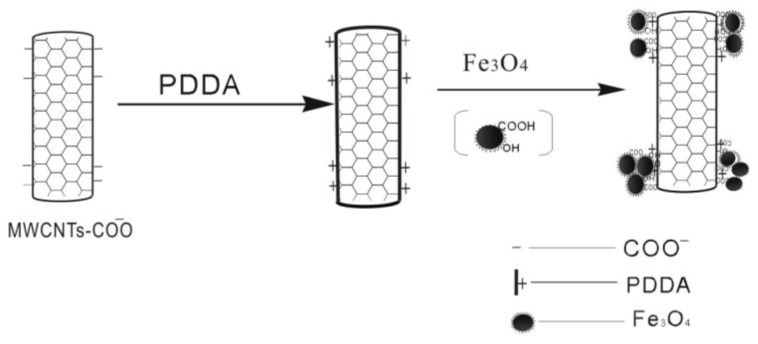
Synthesis strategy of MWCNTs-COO−/PDDA@Fe3O4 MNPs.